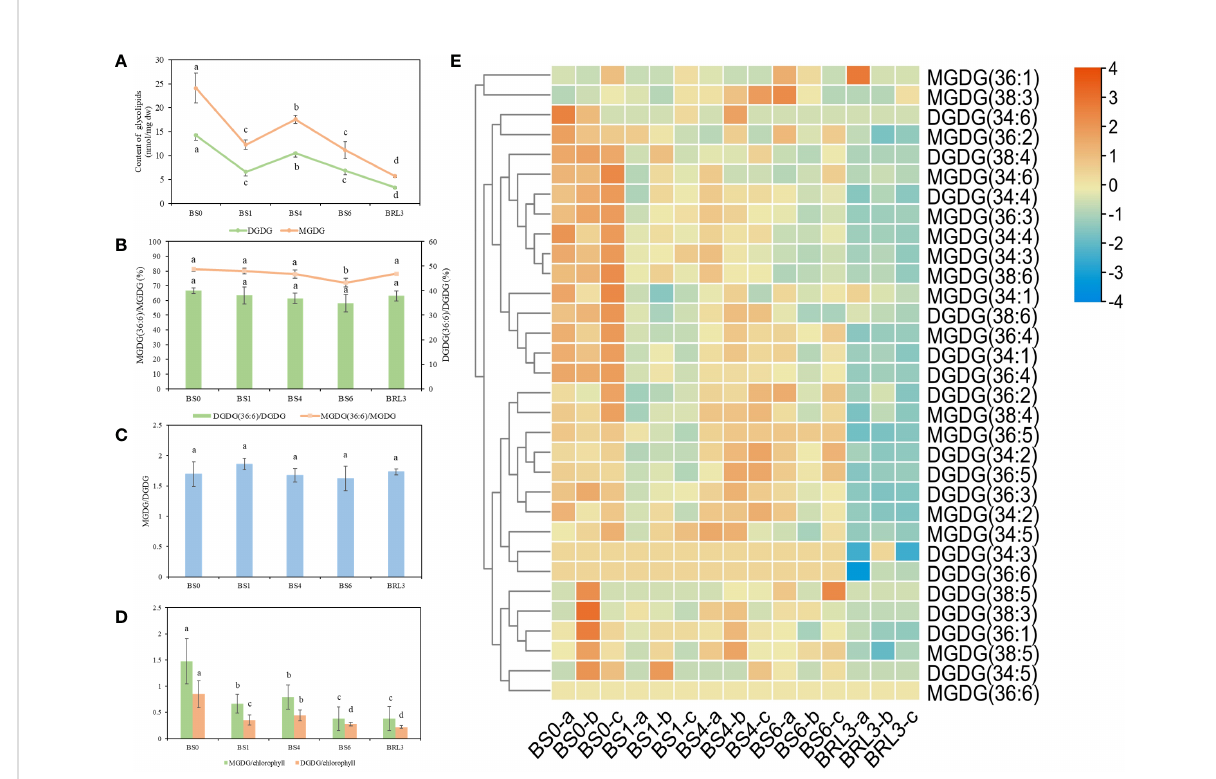
FIGURE 4 Changes in glycolipids in BJG after shading and light recovery treatments. (A) Changes in MGDG and DGDG contents in BJG after shading and light recovery treatments. (B) The ratio changes in the MGDG (36:6)/MGDG and DGDG (36:6)/DGDG ratios after shading and light recovery treatments. (C) The changes in the MGDG/DGDG ratio after shading and light recovery treatments. (D) The changes in the MGDG/chlorophyll and DGDG/chlorophyll ratios after shading and light recovery treatments. (E) Heatmap of glycolipid changes. Data and error bars are the mean ± SD (n = 3). Different lowercase letters indicate a signi fi cant difference between the means at P <0.05. Each colored cell on the map corresponds to the content of different lipid species. Orange color indicates a high content, and blue color indicates a low